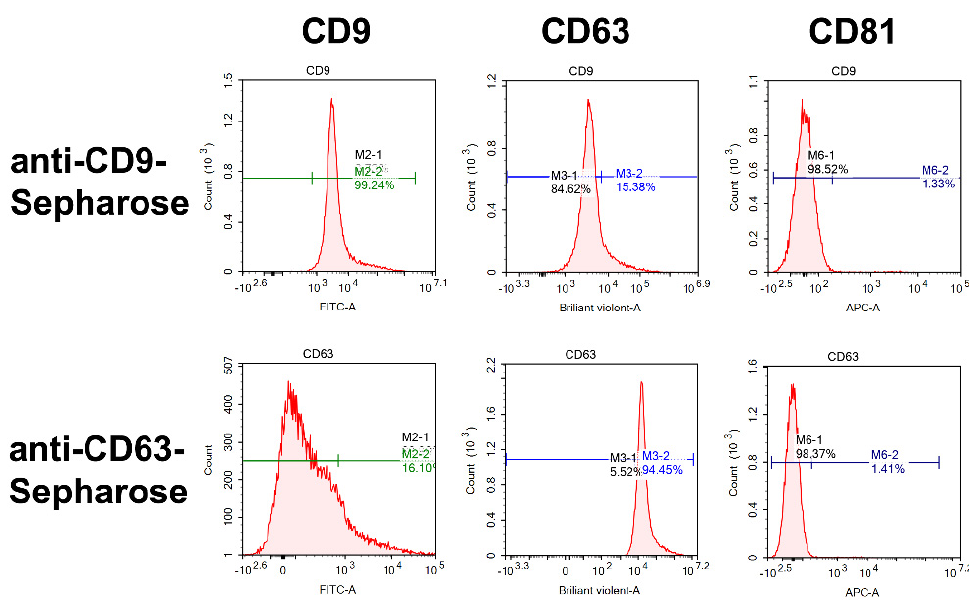
Figure 5. Flow cytometry analysis of P2 + P3 subfractions eluted from anti-CD9- and anti-CD63- Sepharose. Relative amounts of exosomes containing CD9 (left panel), CD63 (central panel), and CD81 (right panel) are shown.